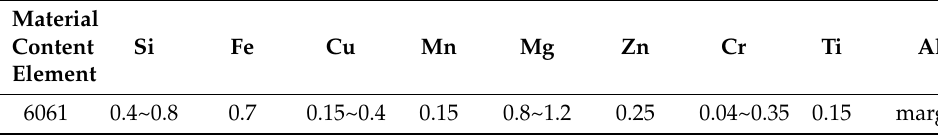
Table 1. Main chemical composition of 6061 aluminum alloy (%) [16].